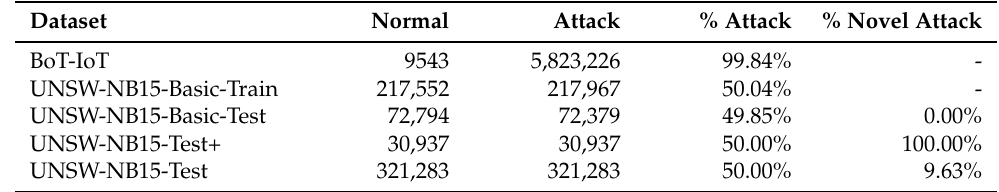
Table 6. Dataset summary showing the number of records corresponding to normal and malicious traffic, the corresponding percentage of attacks, and the percentage of novel